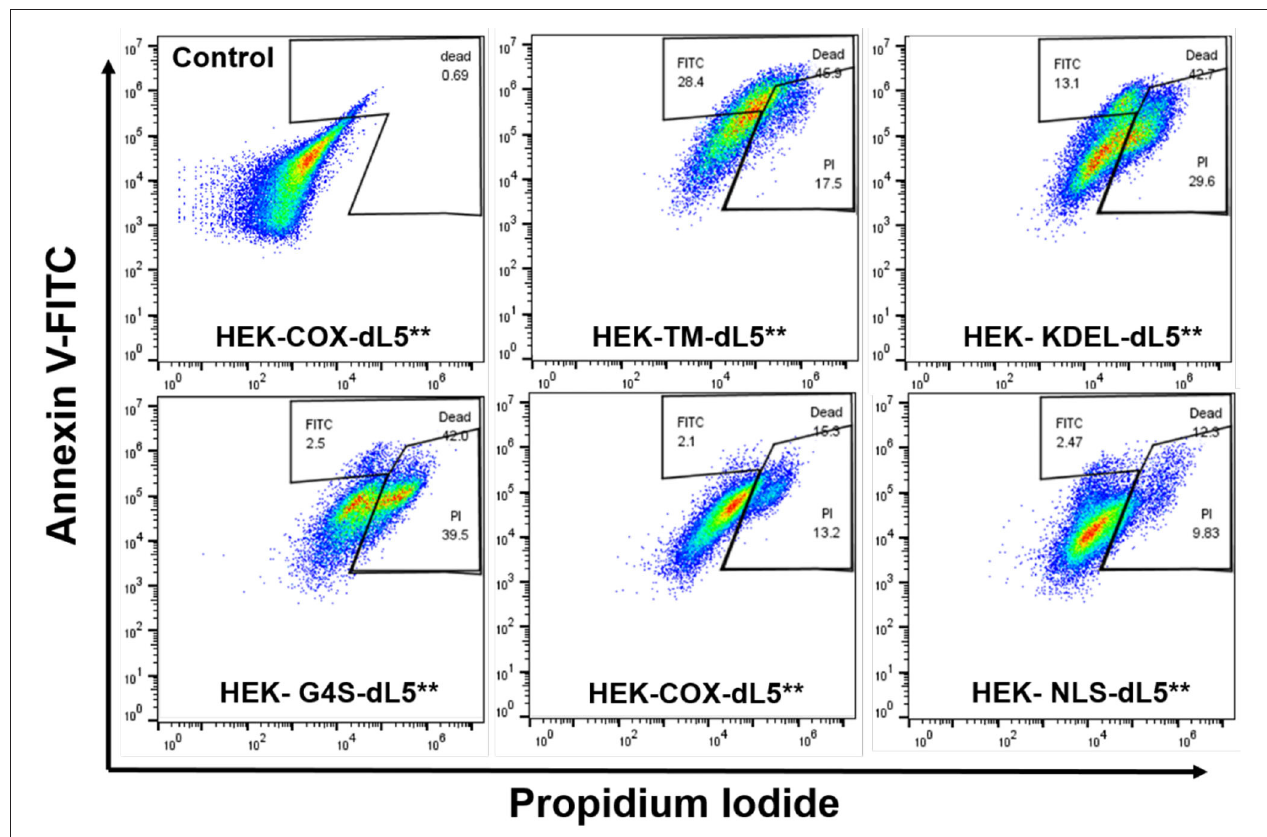
FIGURE 4 | Flow cytometry analysis of five different dL5**-expressing HEK cells incubated with MG2I-ester (500nM) and exposed to 28.8 J/cm 2 of 660-nm LED illumination (160 mW/cm 2 , 180s) (Control HEK-COX-dL5** cells without dye exposure). Different subcellular localization of 1 O 2 results in induction of distinct cell death pathways as detected in indicated gate regions with Annexin V-FITC and PI staining, with varied efficacies.